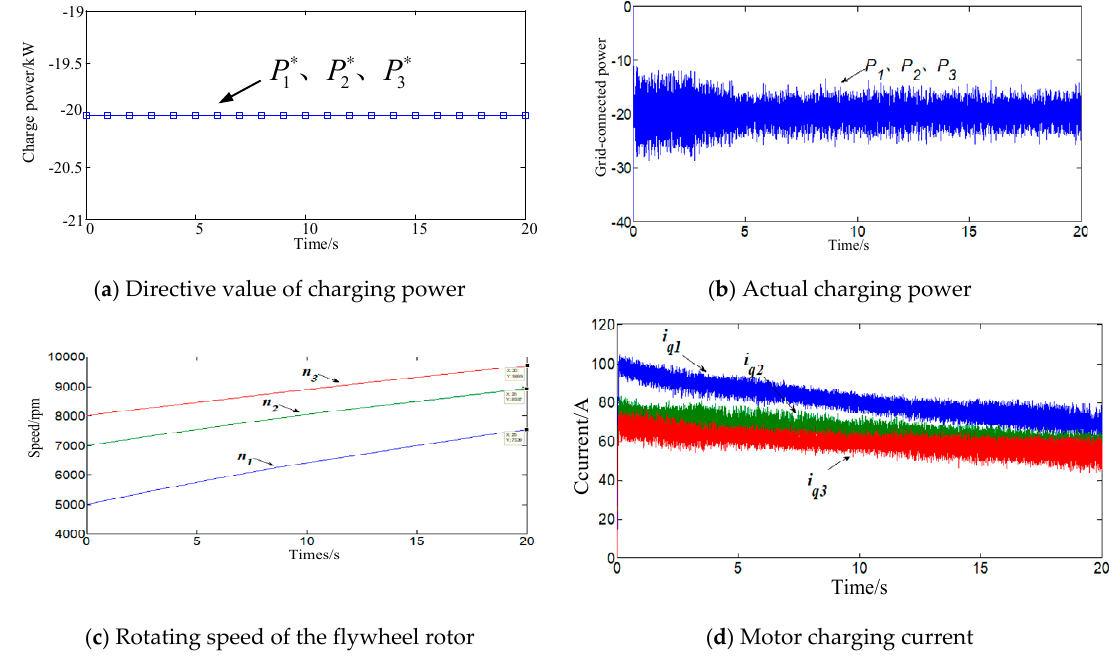
Figure 15. Simulation waveforms of power charging by equal distribution.